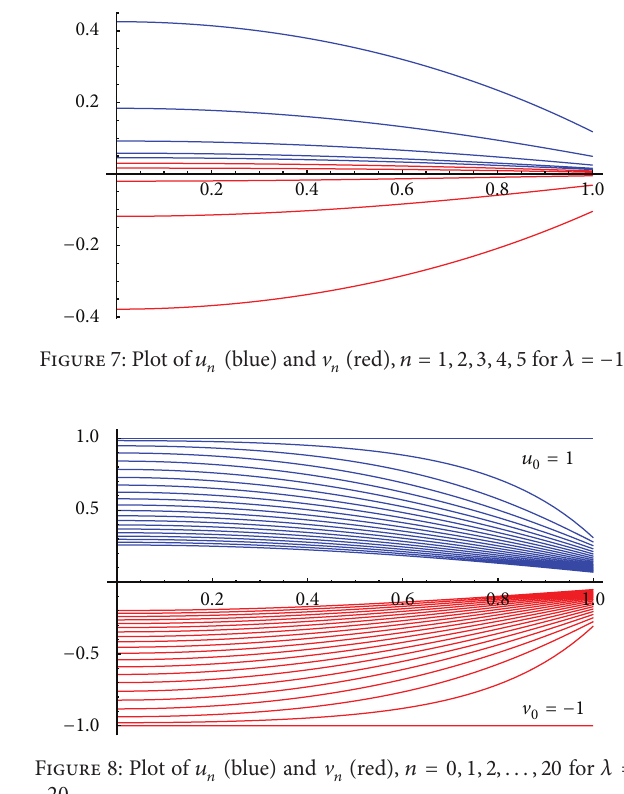
Figure 4: Plot of 𝑢 𝑛 (red) and V 𝑛 (blue), 𝑛 = 0, 1, 2, 3,4 for 𝜆 = 2.3 .